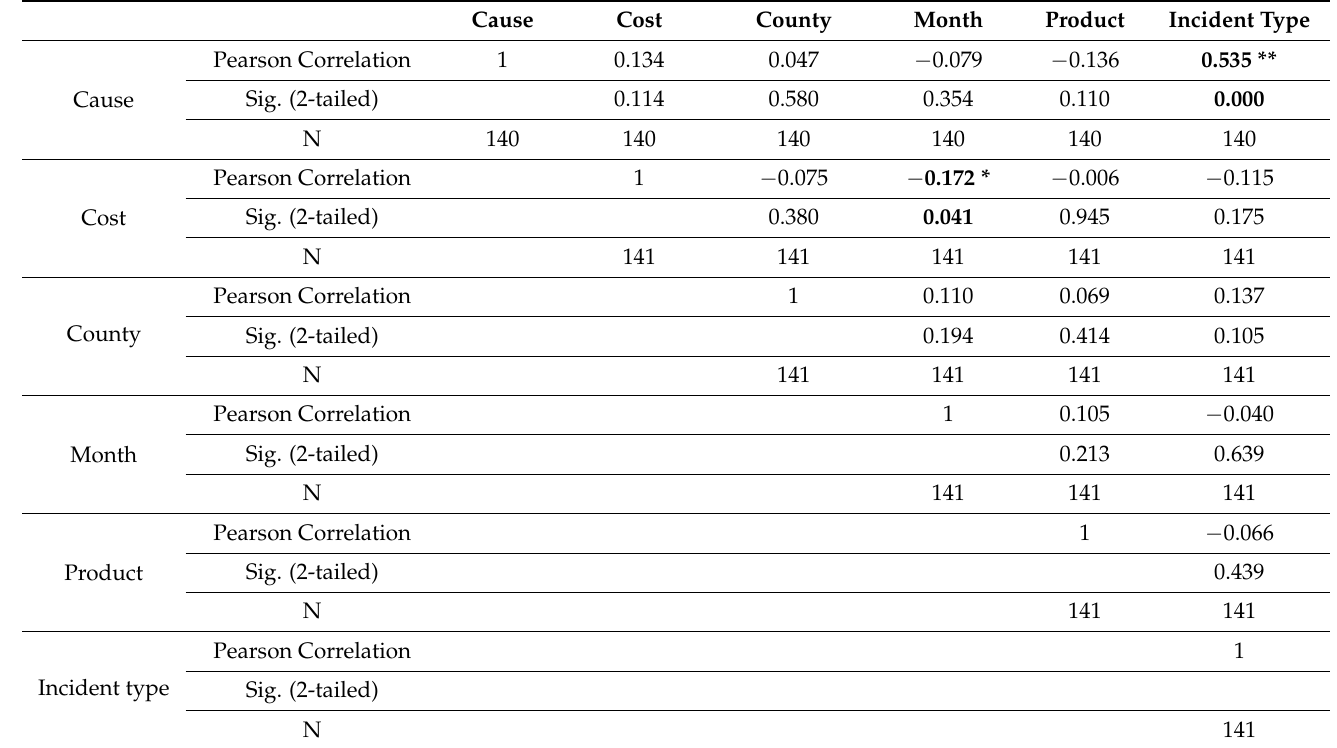
Table 23. Pearson correlation